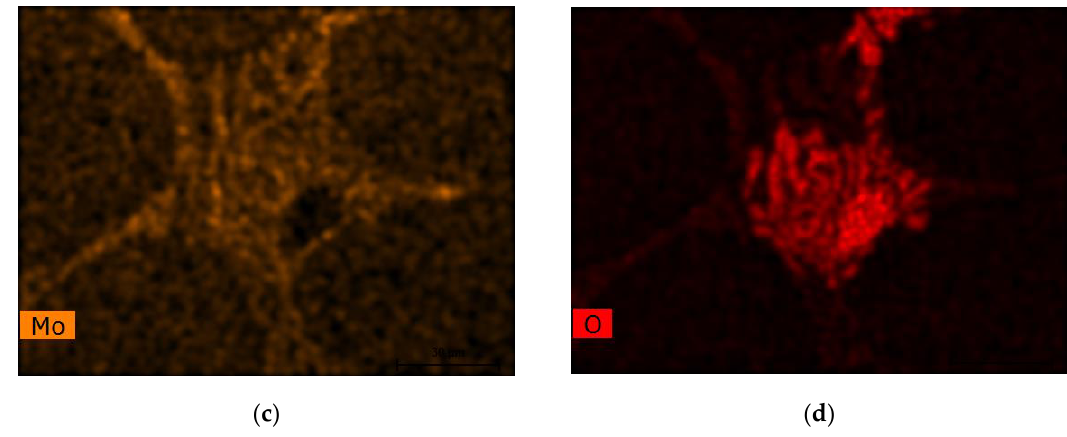
Figure 4. Oxidized inter eutectic matrix area after 2500 cycles at 700 °C: ( a ) BSE micrograph; and elemental distributions of ( b ) Cr, ( c ) Mo and ( d ) O.